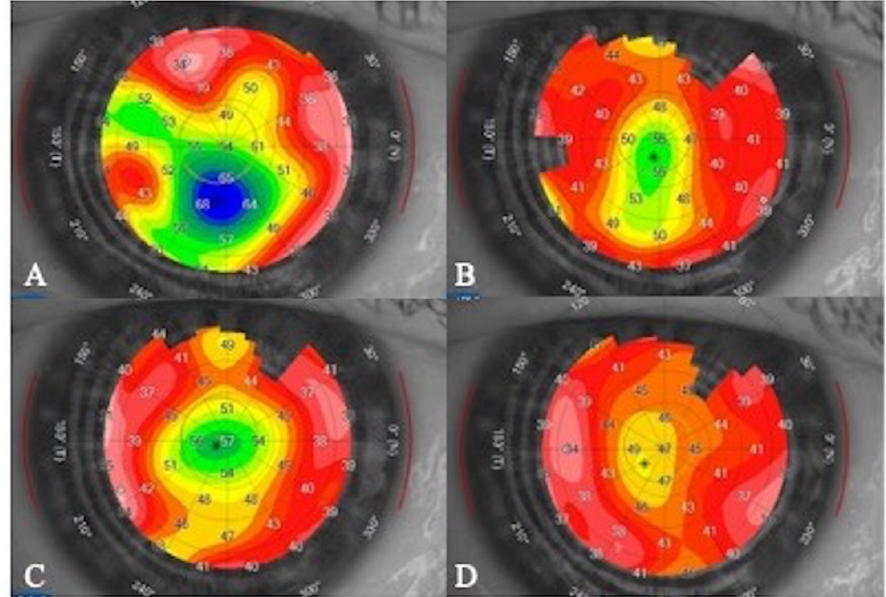
Figure 3. Corneal epithelial thickness (CET) mapping during monthly infusions of belamaf in a patient with belamaf keratopathy. ( A ): Before the second infusion showing a localized transitory CET increase; ( B – D ): Progressive reduction in CET over time, respectively, before the third, fourth and fifth infusion (“plateau phase”).